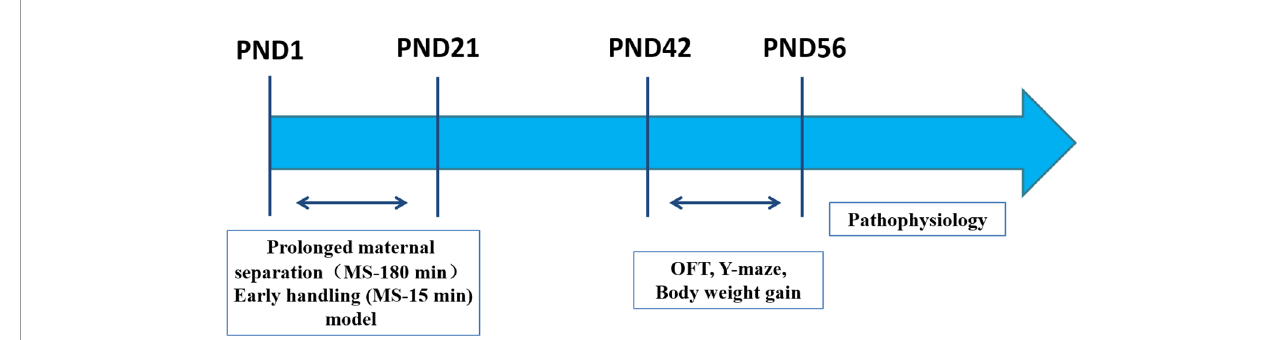
FIGURE 1 | Experimental outline. Male offspring rats were studied in parallel throughout the experiment. Two postnatal manipulations were used. PMS (MS-180): Prolonged maternal separation (MS) consists of daily separation of offspring from their mother for 180 min PND 1 ‑ 21. EH (MS-15): Early handling daily 15-min separation of offspring from their mother on PND 1 ‑ 21. Pathophysiology (ELISA analysis, immunohistochemistry analysis, Western blot analysis). PND: postnatal day. OFT: Open- fi eld Test on PND 42. Y-maze on PND 42 ‑ 44. Body weight gain on PND 7 ‑